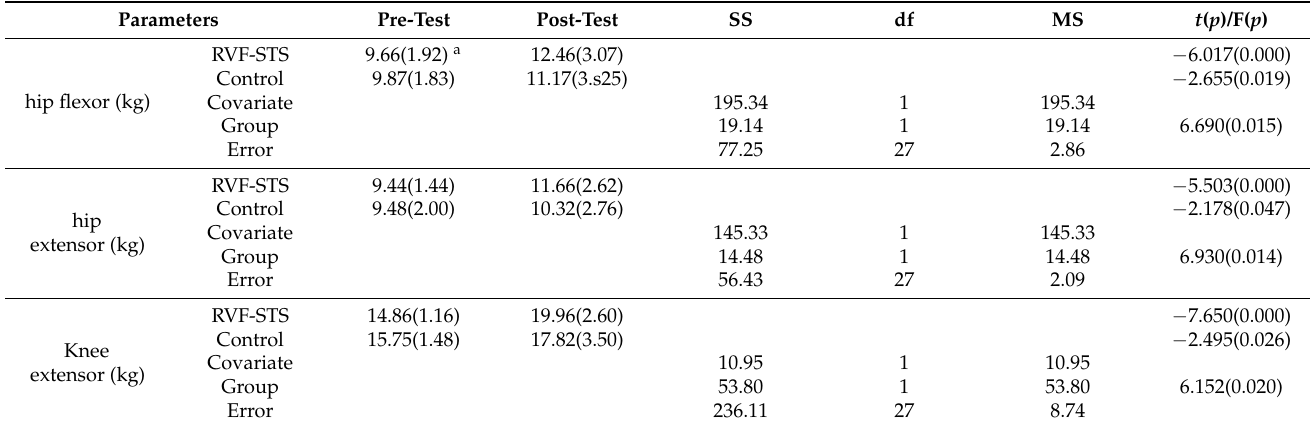
Table 3. Comparison of muscle strength of the lower extremities ( N = 30).